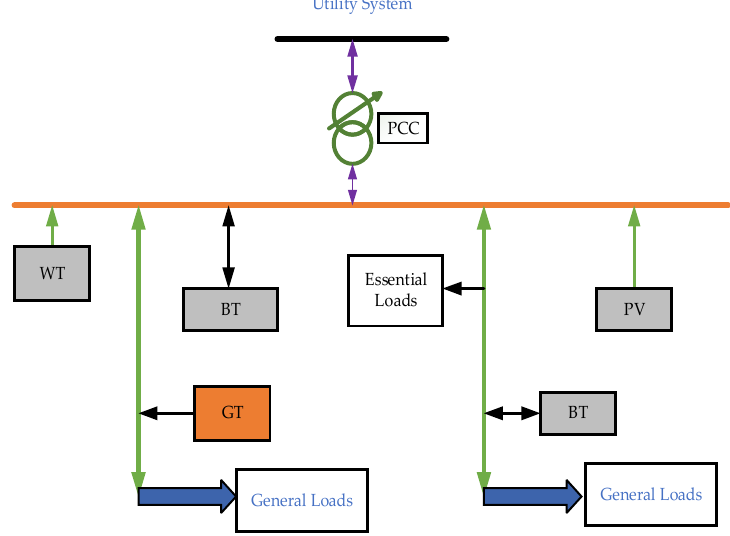
Figure 5. Typical architecture of the microgrid system.